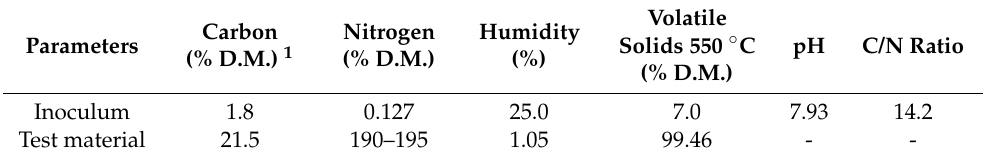
Table 7. Inoculum and test material